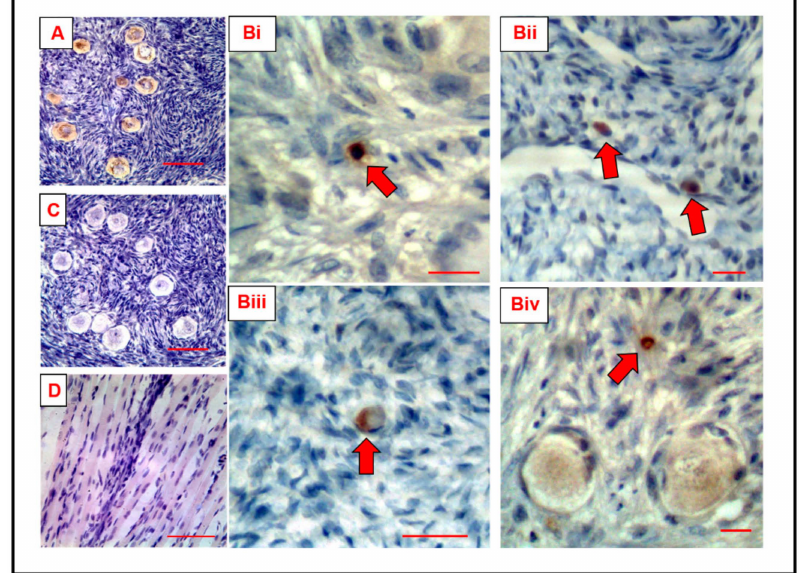
Figure 1. DEAD-box helicase 4 (DDX4) immunohistochemical staining of human ovarian tissue and rat skeletal muscle. ( A ) DDX4-positive (brown staining) germ cells (oocytes) in a section of ovarian